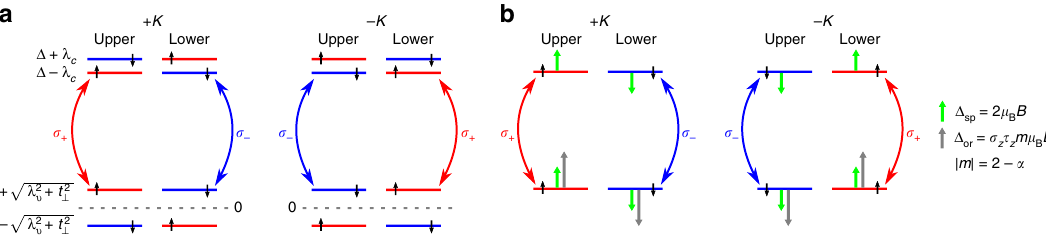
Fig. 3 Origin for Zeeman splitting in bilayer. a Single-particle energy states at ± K -points of bilayer TMD at zero magnetic fi eld and in presence of interlayer hopping t ⊥ . The spin – valley-layer locking results in optical selection rules such that in both valleys, the spin degree of freedom is locked to the emission helicity. b Schematic diagram of the Zeeman splitting in bilayer MoTe 2 under positive magnetic fi eld at ± K -points. Red (blue) transition indicates the PL emission with photon energy E + ( E − ) and circular polarization σ + ( σ − ). The upper and the lower layer in the same valley have opposite spin. Green and gray arrows show the magnetic moment contributions of the spin and atomic orbital to the Zeeman splitting, respectively. In the presence of a positive magnetic fi eld, the spin contributions cancel, whereas the intracellular or atomic orbital contribution leads to E < E − in both the +